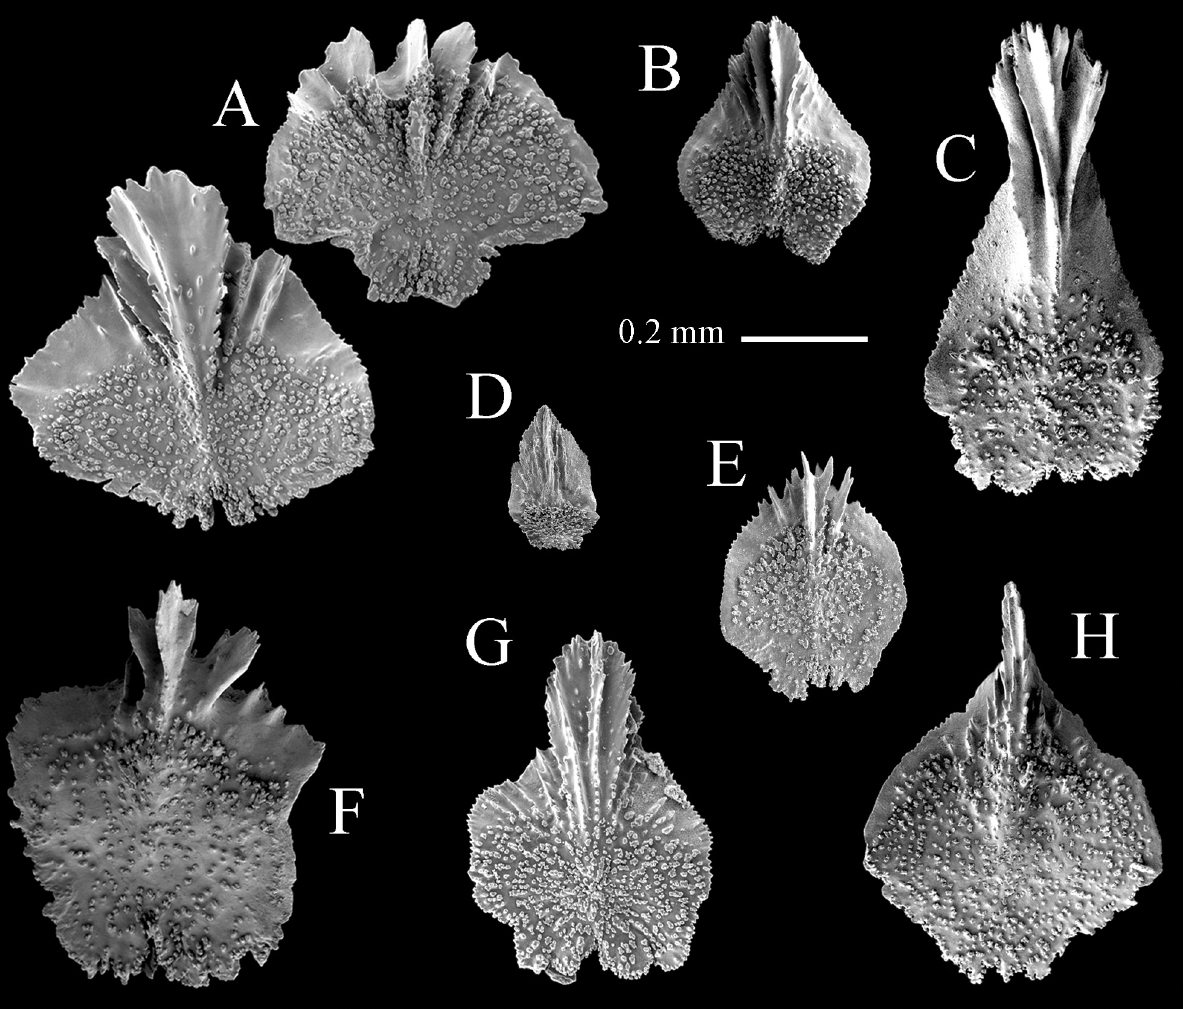
Fig . 19. – Comparison of marginal scales, inner surface view, from species included in subgenus Epithouarella : A, Thouarella viridis Zapata-Guardiola and López-González, 2010, holotype (ZIZMH C11744); B, T. regularis (Wright and Studer, 1889), lectotype (BMNH 1889.5.27.60); C, T. dispersa Kükenthal, 1912, holotype (ZMB Cni 5468); D, T. vitjaz sp.nov., type (IORAS IV-9-Alc-010-002); E, T. crene- lata Kükenthal, 1907, syntype (ZMB Cni 6081); F, T. grandiflora Kükenthal, 1912, holotype (MPUW 44); G, T. chilensis Kükenthal, 1908, type fragment (ZMB Cni 6079); H, T. affinis Wright and Studer, 1889, holotype (BMNH 1889.5.27.44). [*outer surface